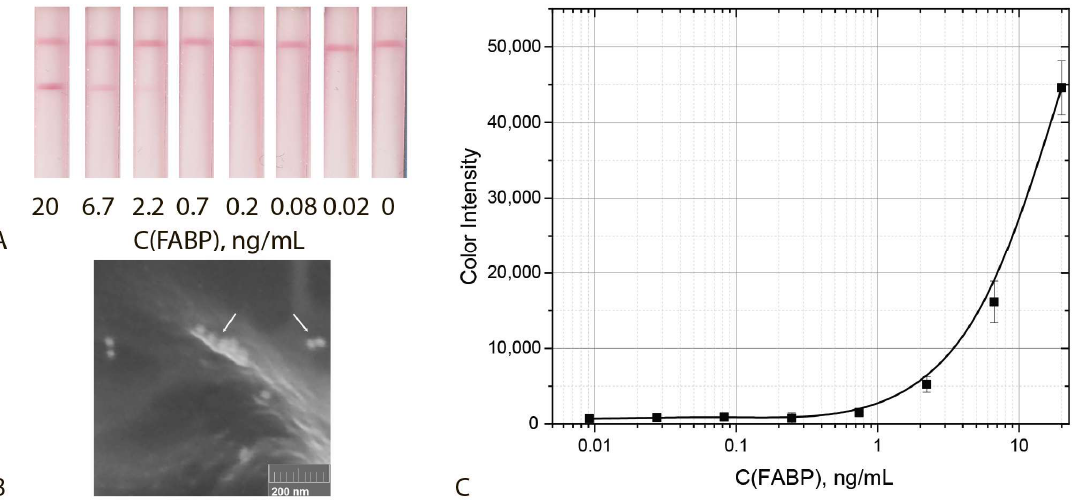
Figure 8. ICA with the use of GNPs aggregation: Appearance of test strips ( A ), SEM image of the sGNPs aggregates bound in the analytical zone ( B ) and calibration curve for FABP detection in serum ( C ) ( n = 5).